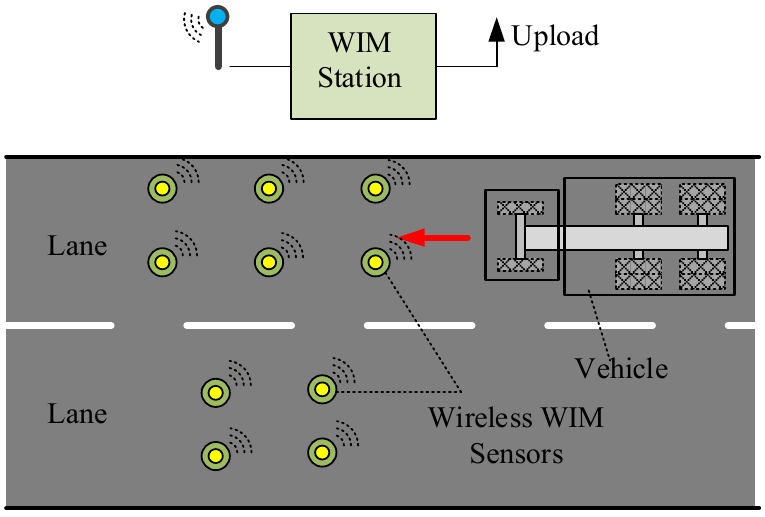
Figure 5. The schematic diagram of a distributed WIM system.